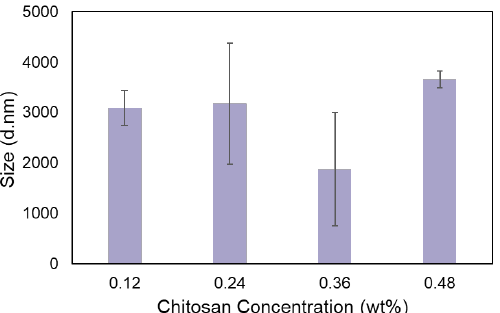
Figure 2. Effect of chitosan concentration on the ink’s average size. Data points represent mean ± SD ( n = 3).